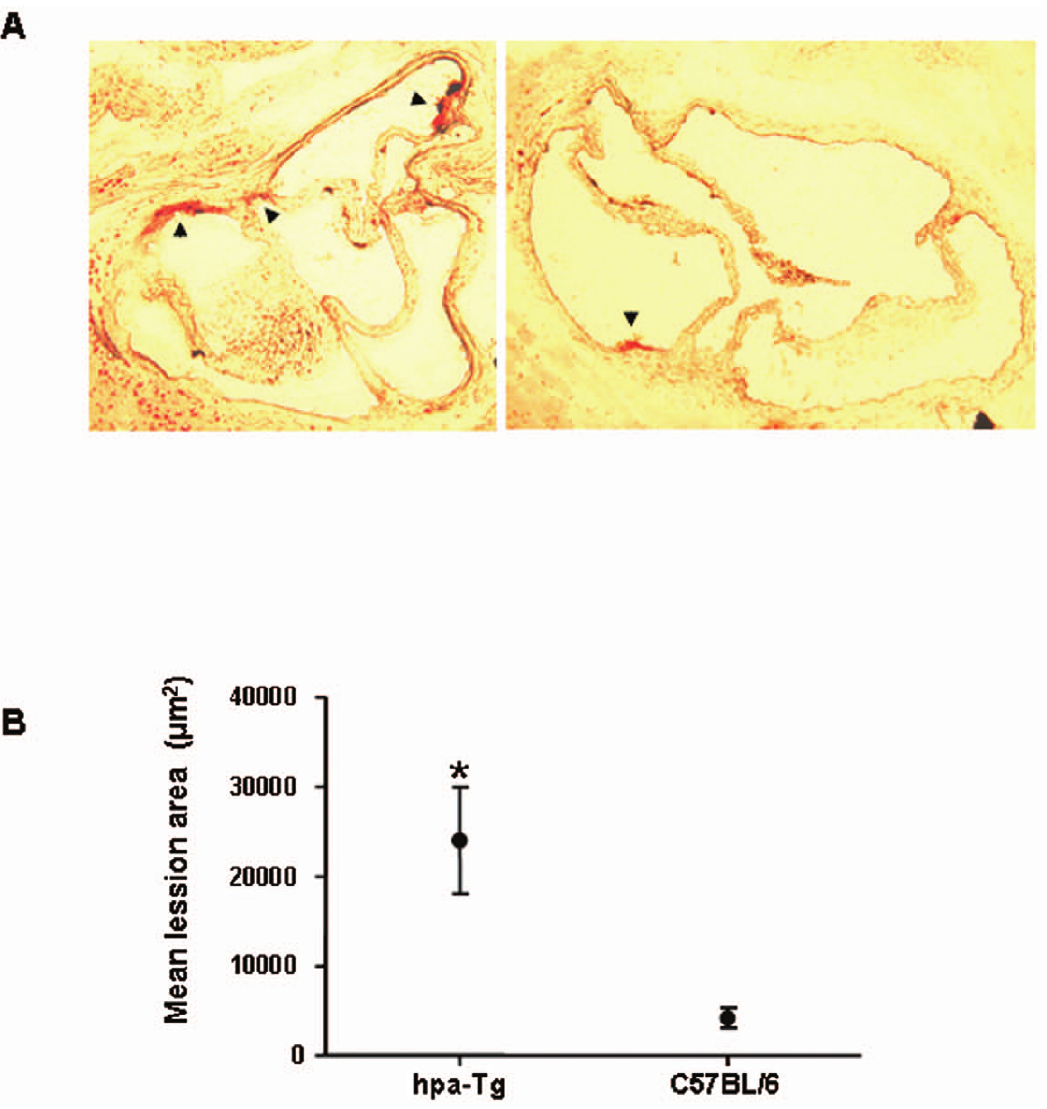
Figure 5. Fatty streaks in hpa-Tg and C57BL/6 mice. (A) Frozen sections of aortic root from hpa-Tg and C57BL control mice (n=15 for each group) were stained with Oil-Red-O for lipid content. (B) Mean lesion area in heparanase over-expressing mice was significantly higher compared to control mice, p , 0.001.